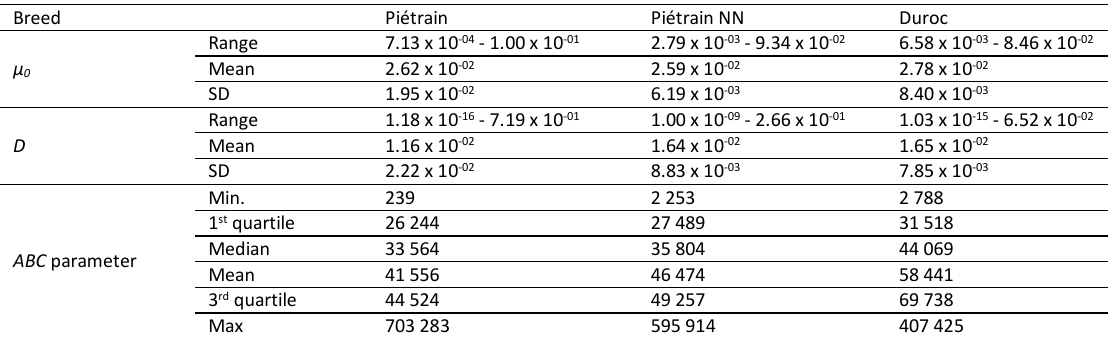
Table 2. Descriptive statistics of the parameters for the growth curve modelling in the three pig lines analyzed